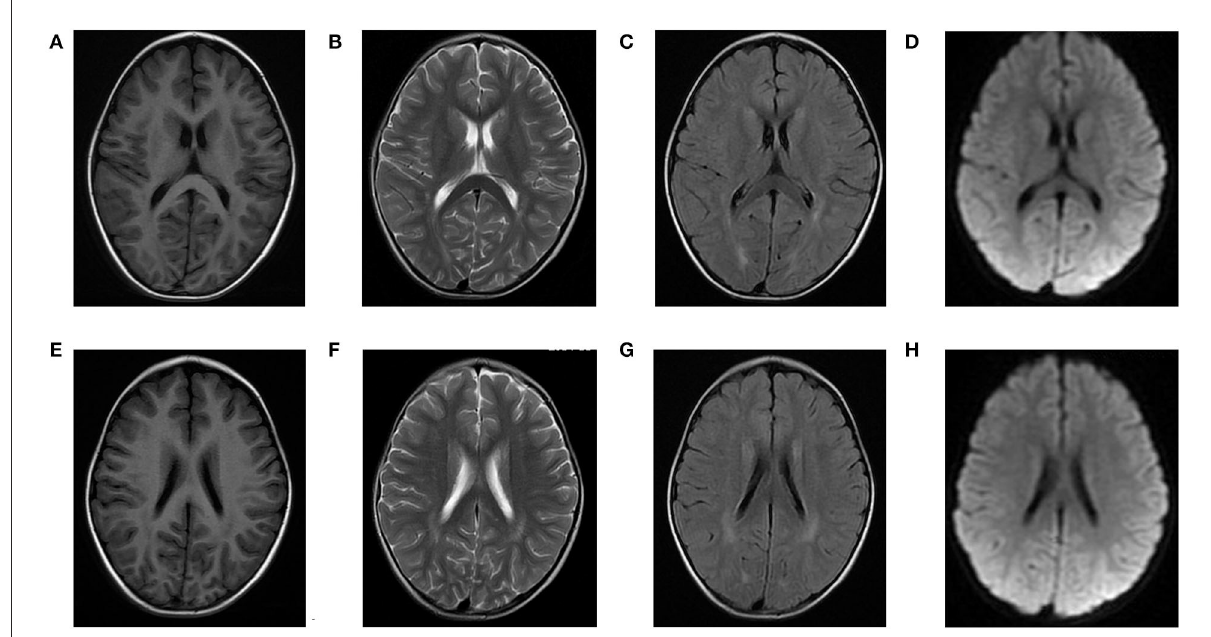
FIGURE1 Brain magnetic resonance (MR) images of the patients. (A–D) and (E–H) show scattered high signal intensity in the bilateral frontal and parietal periventricular white